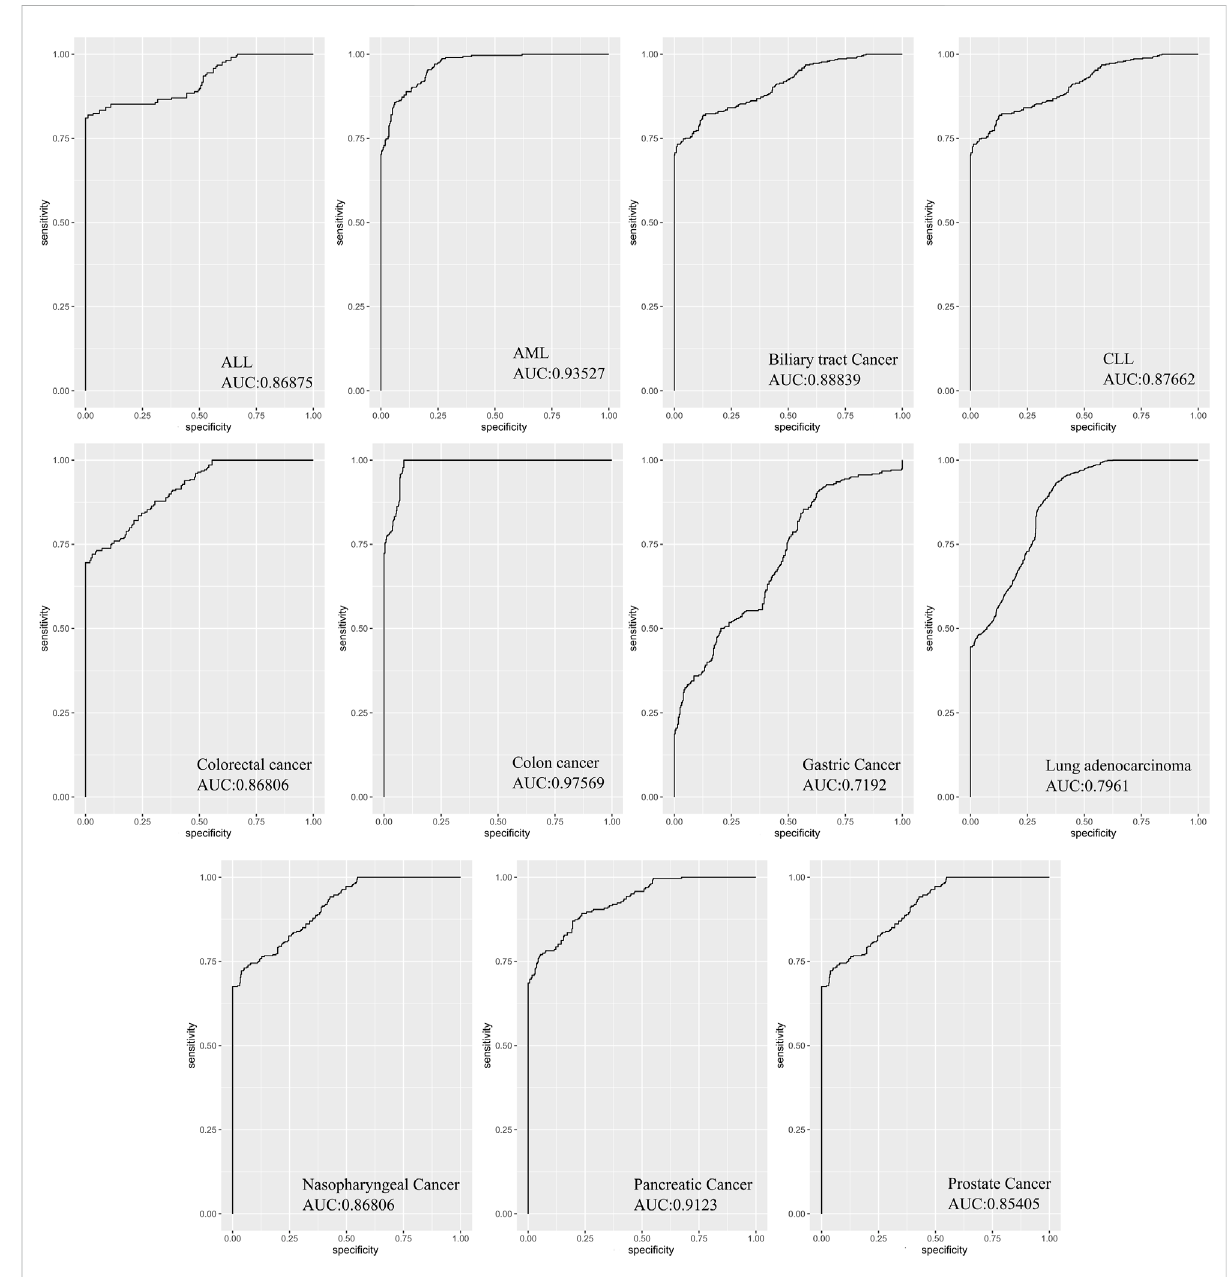
FIGURE 5 The area under curves analysis for seven DEMs as a signature in eleven cancers. AUC analysis of all seven miRNAs as a signature panel checked with sensitivity and speci fi city > 80% and p -value < 0.05. The best model performance was demonstrated in Colon